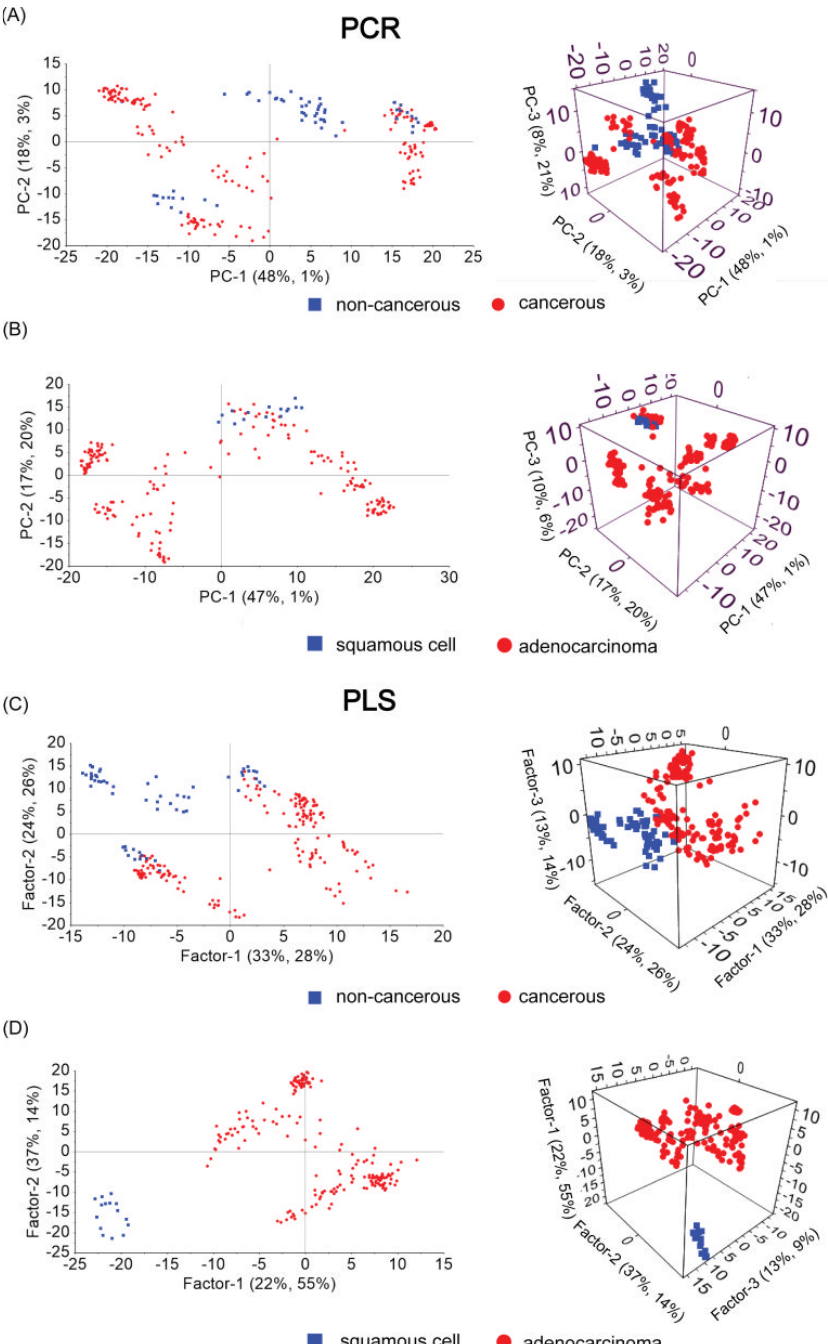
Figure 3. The scores plots in 2D and 3D projections for non-cancerous vs. cancerous and for squamous cell vs. adenocarcinoma samples for PCR method ( A , B ) and for the PLS ( C , D ), respectively.